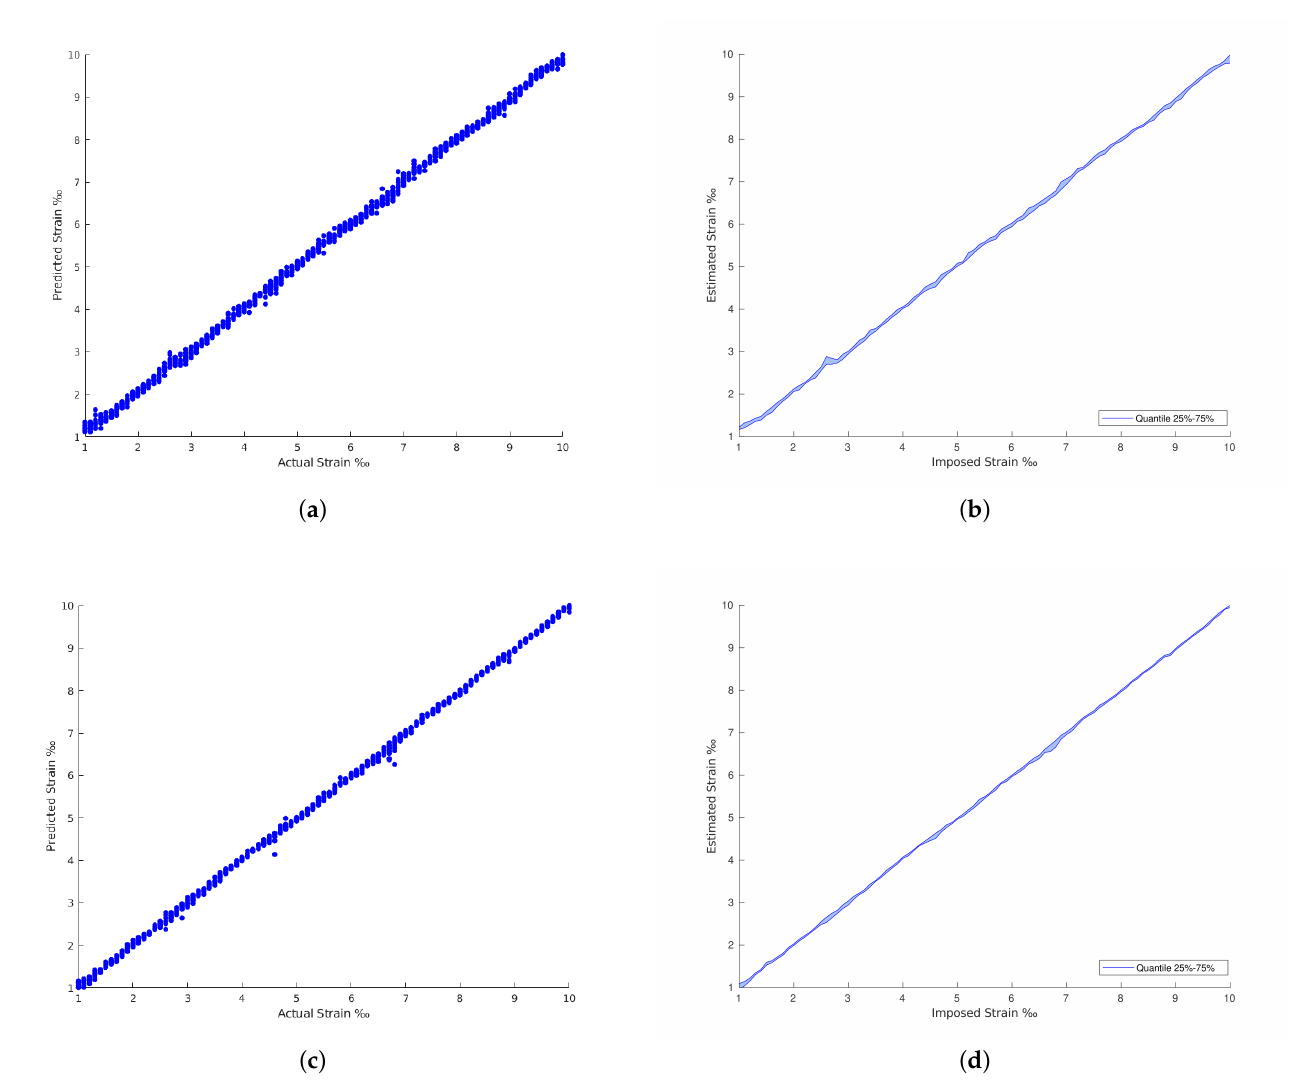
Figure 12. ResNet and GoogLeNet results. ( a ) GoogLeNet with regression predictions. ( b ) GoogLeNet with regression predictions by quantile variations. ( c ) ResNet with regression predictions. ( d ) ResNet with regression predictions by quantile